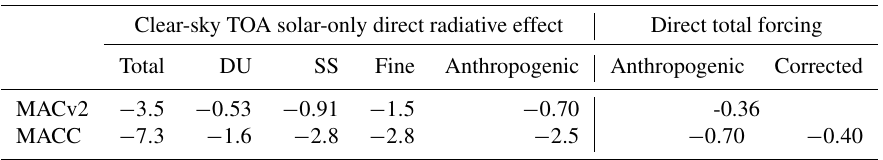
Table G2. Comparison of present-day aerosol-associated aerosol radiative effects between the MACv2 aerosol climatology and the MACC reanalysis data (in Wm − 2